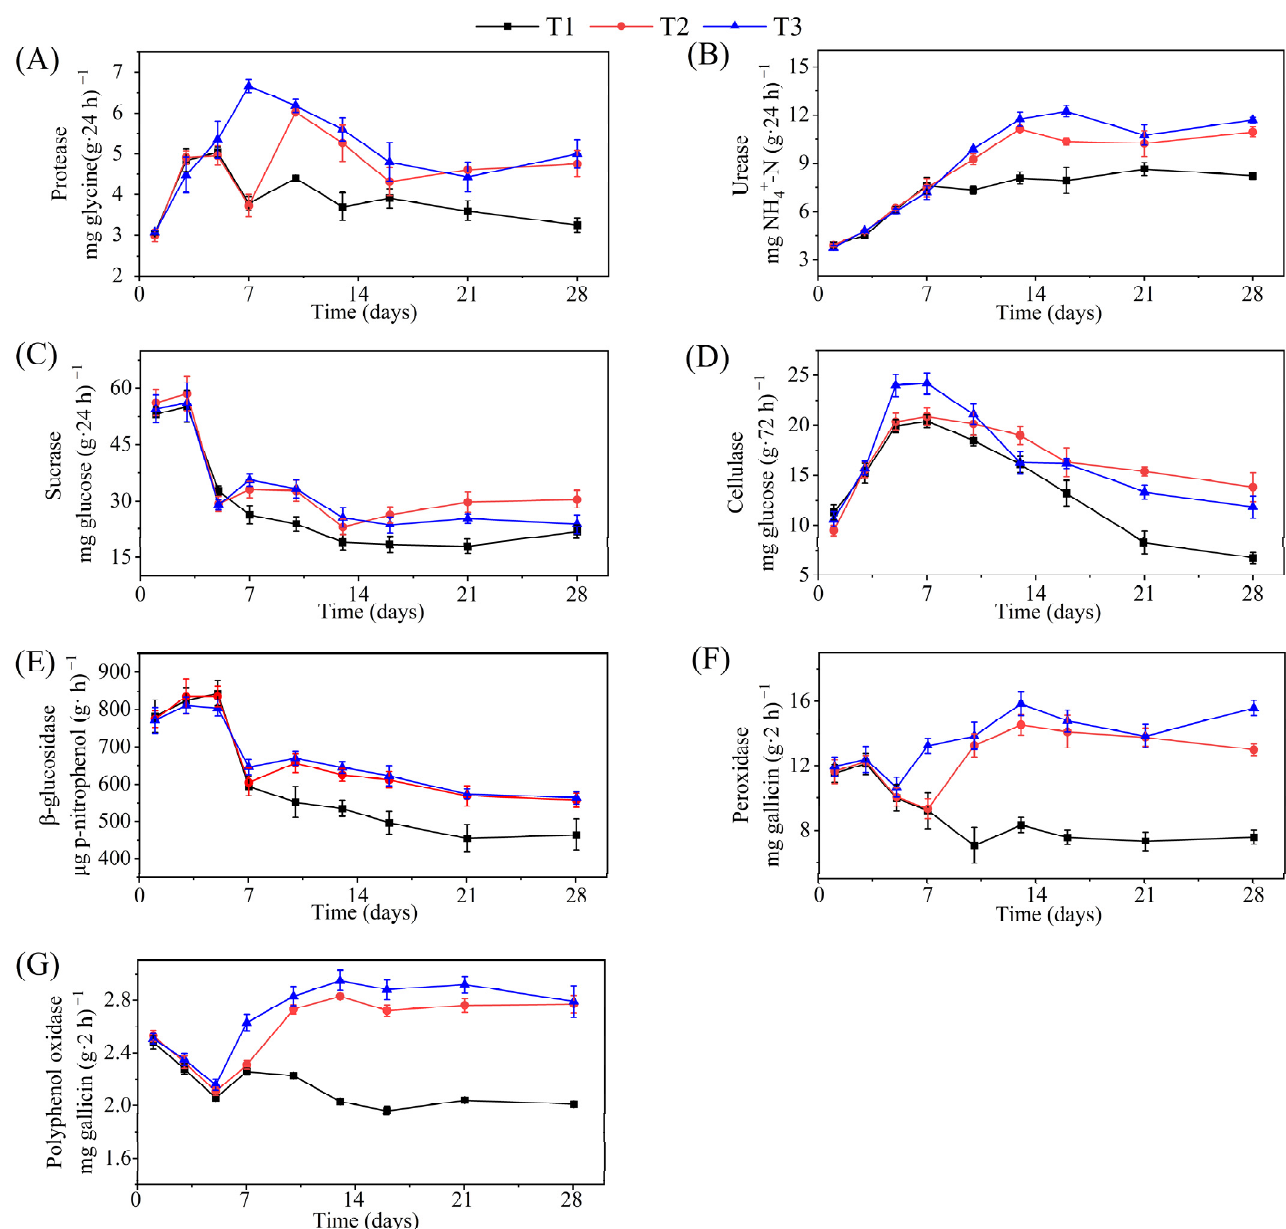
Figure 1. Changes in protease ( A ), urease ( B ), sucrase ( C ), cellulase ( D ), β -glucosidase ( E ), peroxidase ( F ), and polyphenol oxidase ( G ) activity during